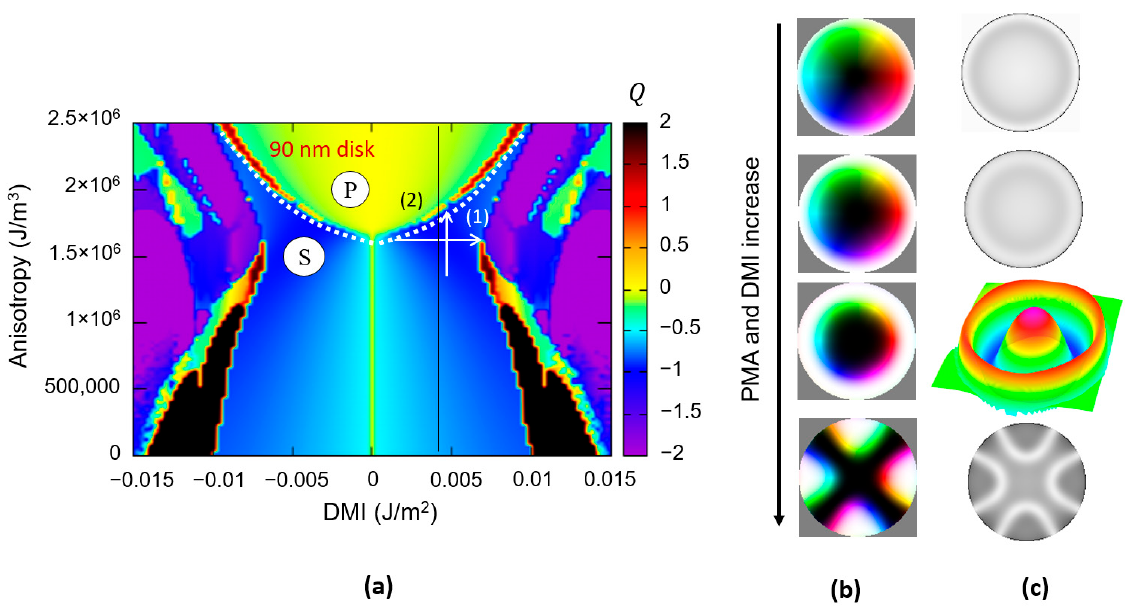
Figure 15. ( a ) Ground state diagram DMI-PMA-Q (90 nm circular disk) with two analysis paths: (1): fixed PMA = 1.72 × 10 +6 J/m 3 and (2): fixed DMI = 5 mJ/m 2 . ( b ) Micromagnetic chiral ground states and ( c ) Total energy density landscapes evolution when the PMA and the DMI increase along the paths (1) and (2). In ( a ), the white dotted lines are guiding lines for the threshold from (S) to (P) state, and the black vertical line corresponds to the analysis path used in Figure 13: fixed DMI D ind = 4 mJ/m 2 and variable PMA K u = 0 − 2.5 × 10 +6 J/m 3 .